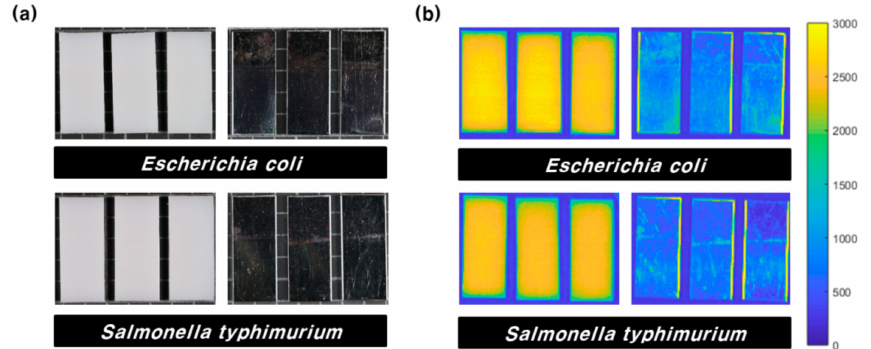
Figure 7. HDPE and SS coupons of bacterial biofilms: ( a ) RGB images and ( b ) hyperspectral images of the 551.8 nm